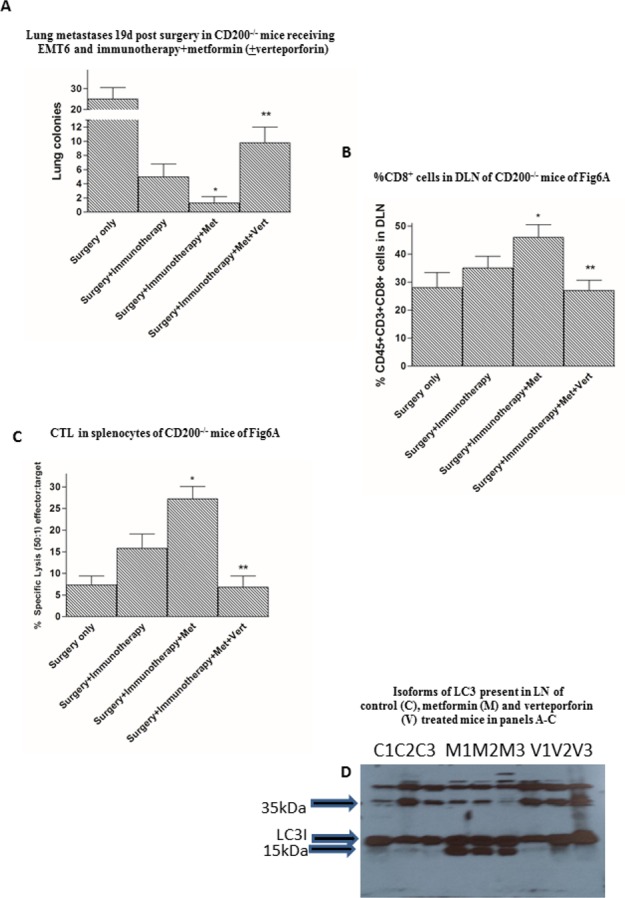
Effect of verteporfin on metformin-associated augmentation of host resistance to EMT6 tumor growth and metastasis in CD200-/- mice.A. CD200-/- EMT6 tumor bearing mice immunized with irradiated EMT6 cells and CpG as adjuvant after primary tumor resection, with and without daily administration of metformin and verteporfin (an autophagy inhibitor), were sacrificed 19d after surgery and tumor nodules in lung evaluated macroscopically after fixation in Bouin’s solution. B. Single cell suspensions of DLN from mice in panel A were stained for CD45, CD3, and CD8 cell surface expression. C. CTL activity against EMT6 tumor cells in 18hr 51Cr release assays using splenocytes of CD200-/- mice (50:1 effector:target) shown in panels A and B. In all panels data show mean (±SD) of 4 mice/group. *p<0.05 compared with group receiving surgery and immunotherapy only (no metformin).**p<0.005 compared with group receiving surgery, immunotherapy and metformin. D. Western blots showing detection of LC3-I (16–18 kDa–top band) and LC3-II (14–16 kDa–bottom band). in LN taken from individual control (C), metformin-treated (M) or metformin and verteporfin-treated (V) mice shown in previous panels. Anti-LC3 (1:200); anti-rabbit HRP (1:5000); 10 minute exposure.